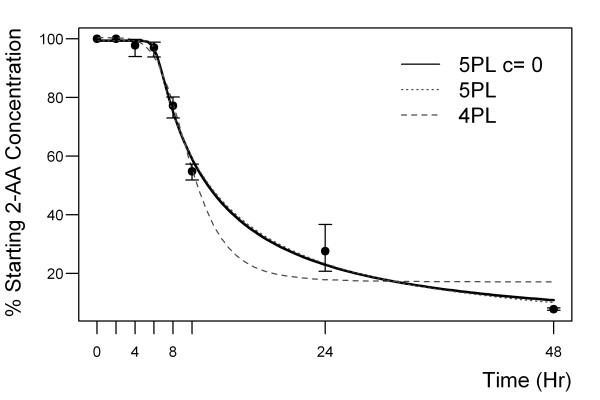
A time degradation graph of 2-AA in glass sampling bulbs. The 2-AA levels (mean and SD) from three replicate experiments are shown and a five parameter logistic function fitted to the degradation curve (11.73 hours (95% CI 10.94, 12.52). 2-AA levels at 8 and 10 hours were significantly less (P < 0.001) than four and six hours.